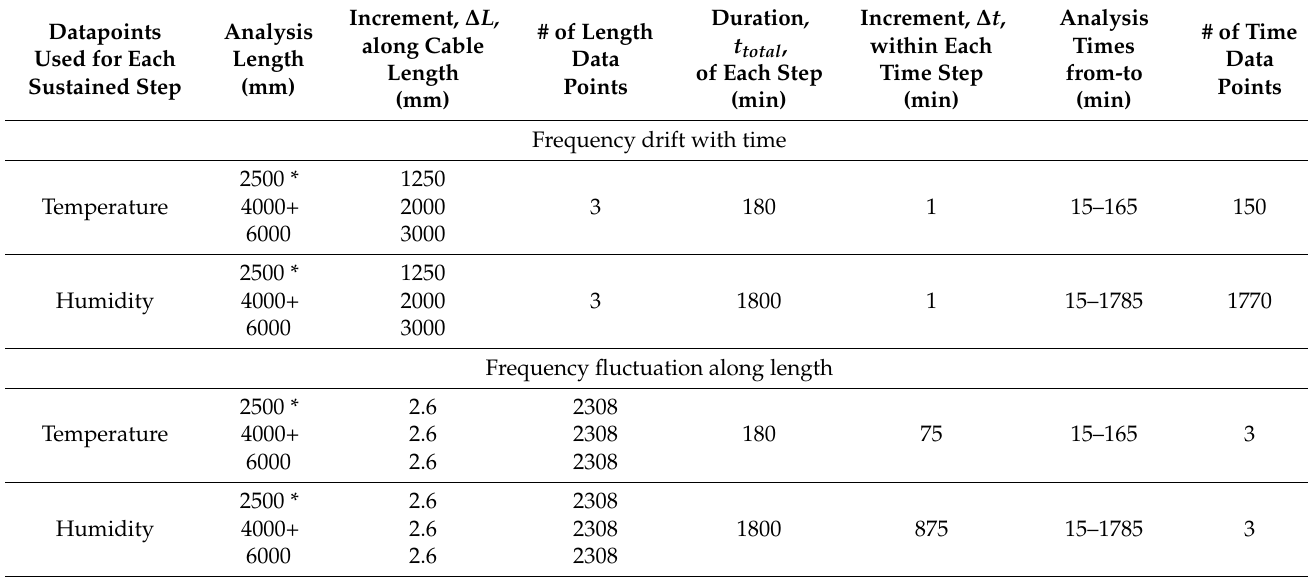
Figure 10. Frequency drift over time during a temperature and humidity step. For the drift analysis the first and last 15 min were neglected, hence 150 min of each temperature step and 1770 min of each humidity step were considered. The grey area represents the 10 min time span in which the mean value was taken to compare to each other. Table 6. Frequency drift and length stability analysis: Cable positions and time spans used for temperature and